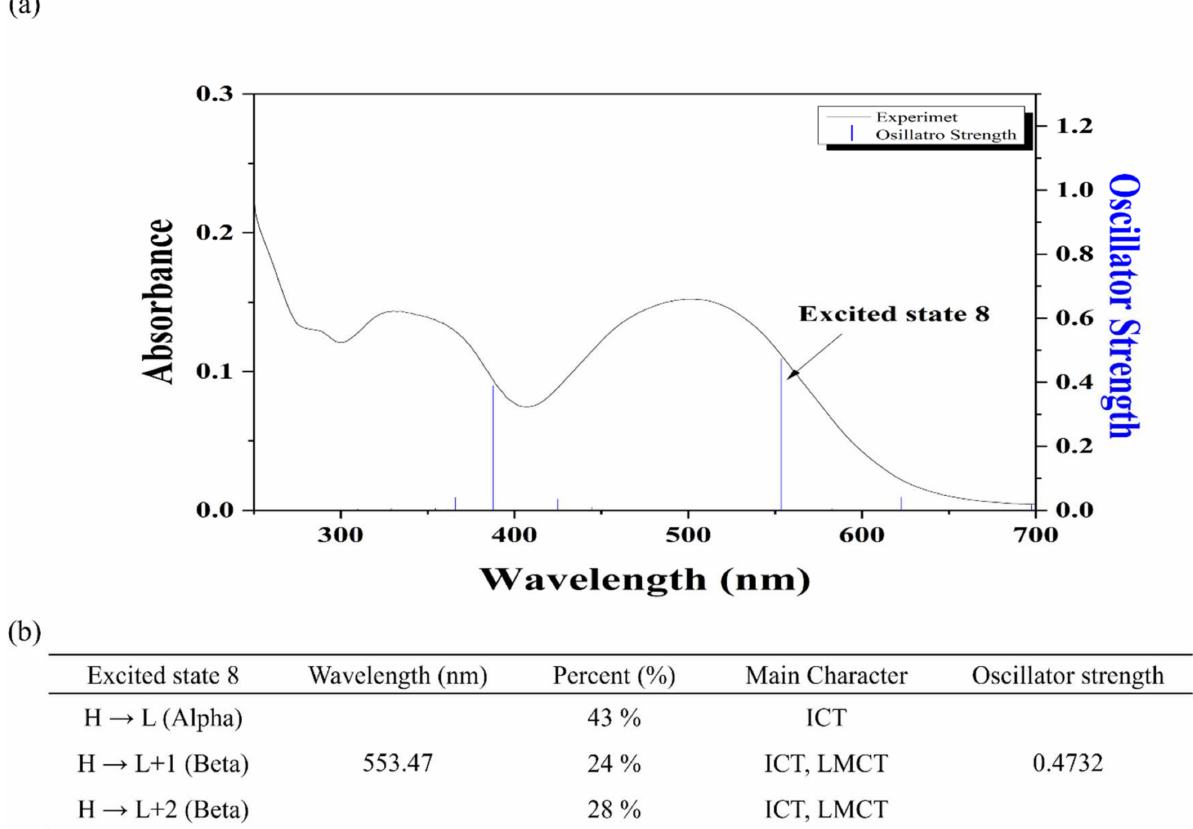
Figure 13. ( a ) The experimental UV-vis and theoretical excitation energies of DPP -Ni 2+ . ( b ) The significant electronic transition energies and MO contributions for DPP -Ni 2+ (H = HOMO and L =